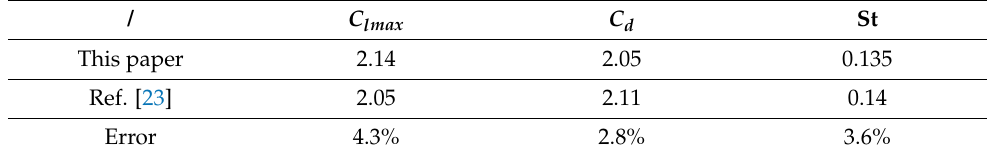
Table 1. Comparison with the